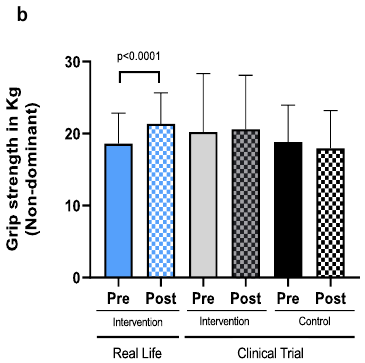
Figure A1. Grip strength in old individuals before and after a six-month intervention. ( a ) Grip strength of the dominant hand. ( b ) Grip strength of the non-dominant hand. Real-Life Intervention n = 50, Clinical Trial Intervention n = 51, Clinical Trial Control n = 49. Bars represent mean ± SD. Statistical analysis was performed with the Student ’ s t test for paired samples and the Wilcoxon test for non-parametric samples.